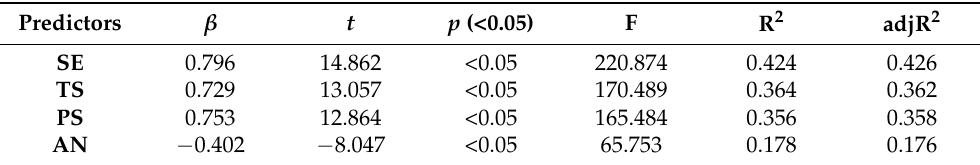
Table 4. Regression analysis for the effect of self-efficacy, teachers’ support, peers’ support, and anxiety on social